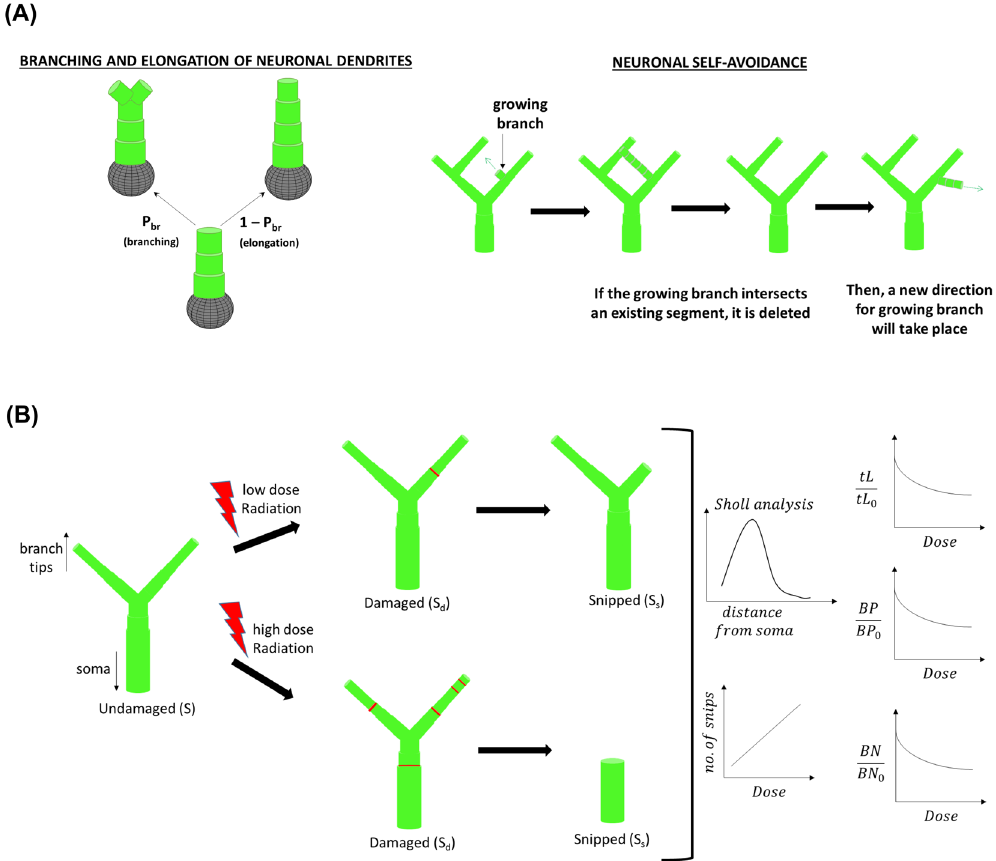
Figure 1. Schematic diagram of ( A ) neuronal dendritic growth model and ( B ) radiation-induced “snipping” of neuronal